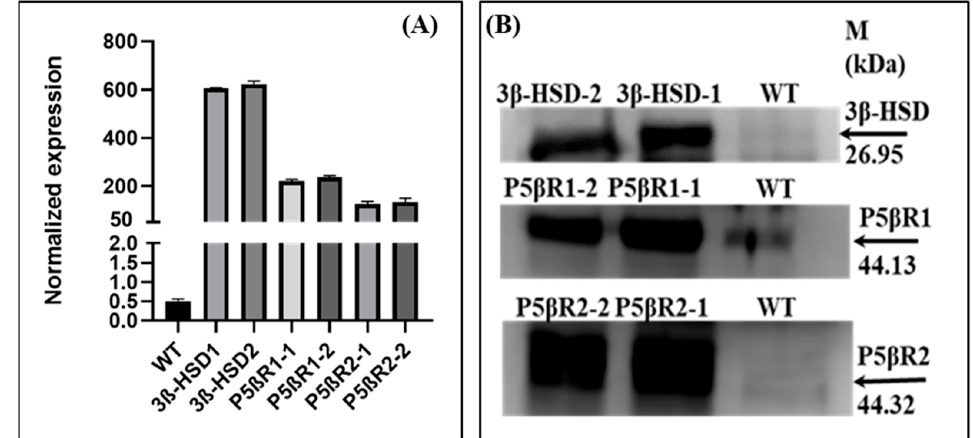
Figure 3. ( A )Transgene expression of the 3 β -HSD , P5 β R1 and P5 β R2 by real time qRT-PCR in independent transplastomic plant lines 3 β HSD-1, 3 β HSD-2, P5 β R1-1, P5 β R1-2, P5 β R2-1 and P5 β R2-2. Real-time reverse transcription-polymerase chain reaction (RT-qRT-PCR) was performed, using gene specific primer set for the 3 β -HSD , P5 β R1 and P5 β R2 . Relative expression levels were normalized against the values of the Actin9 transcripts in WT and the transplastomic lines. Each value represents the mean ± standard error (SE) of three samples from three independent experiments. ( B ) Western blot analysis of 3 β -HSD, P5 β R1 and P5 β R2 in transplastomic lines 3 β -HSD-1, 3 β -HSD-2, P5 β R1-1, P5 β R1-2, P5 β R2-1, P5 β R2-2 and WT tobacco. The molecular weights of the protein were 26.95 kDa, 44.13 kDa and 44.32 kDa for 3 β -HSD, P5 β R1 and P5 β R2, respectively. M: Marker. WT: Wild type. 3 β -HSD-1, 3 β -HSD-2: Two independently generated lines of 3 β -HSD. P5 β R1-1, P5 β R1-2: Two independently generated lines of P5 β R1. P5 β R2-1, P5 β R2-2: Two independently generated lines of P5 β R2.